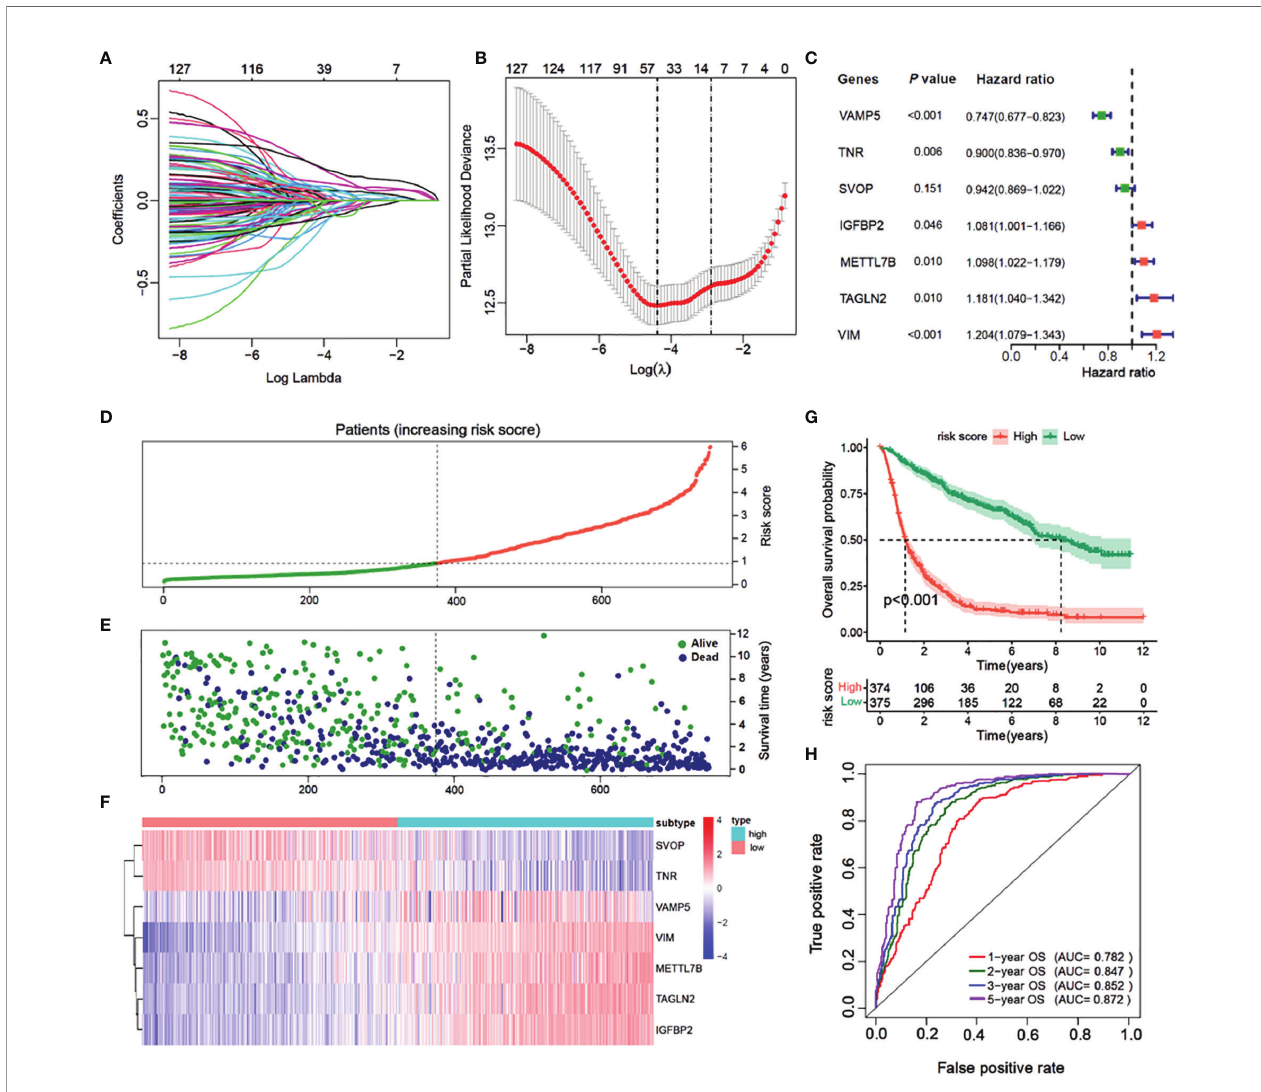
FIGURE 6 | Construction of a prognostic model based on differential genes of immune subtypes. (A) The LASSO coef fi cients pro fi le of the 132 signi fi cate genes selected for overall survival against the log lambda sequence. (B) Ten-fold cross-validated error ( fi rst vertical line equals the minimum error, whereas the second vertical line shows the cross-validated error within 1 standard error of the minimum). (C) Forest plot of 7 immunity-subtype-related genes identi fi ed by multivariate Cox regression. (D) Glioma patients are sorted by risk score, red is high risk, green is low risk. (E) The survival status of Glioma patients, dark blue is dead, light green is alive. (F) The heatmap of the 7-hub gene expression. (G) Kaplan – Meier curve survival analysis between high risk and low risk, red line means high risk group, blue line means low risk group; (H) Time – ROC curve analysis of the 7 hub genes signature, red line means 1-year OS, green line means 2-year OS, blue line means 3-year DFS, purple line means 3-year